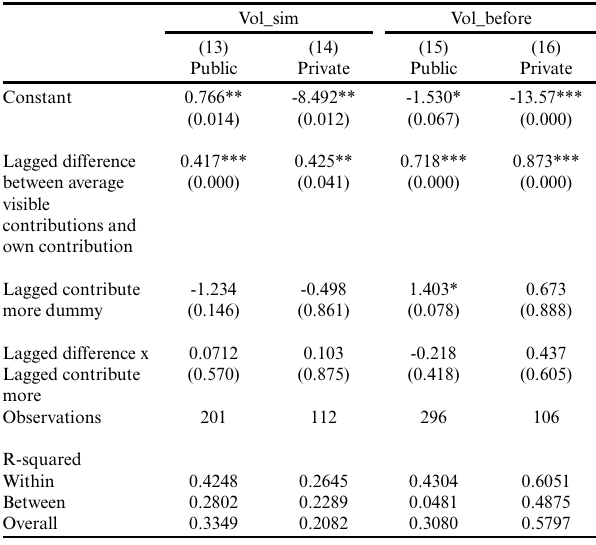
Table 7 . Regression analyses of change in individual level contributions in voluntary